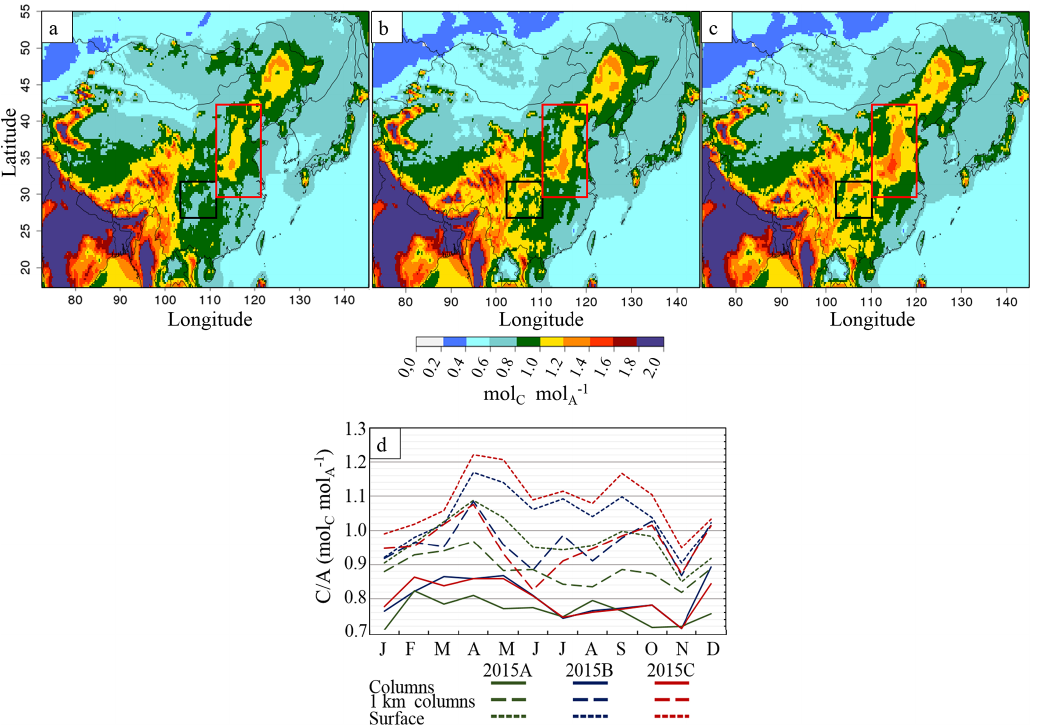
Figure 10. Partial column (0–1km) cation / anion ratio (mol C mol − 1 ) over China for the simulations (a) 2015A, (b) 2015B and (c) 2015C A and (d) monthly variation of C / A ratio over eastern China. Full lines represent ratios derived from columns (up to 12km), dashed lines represent ratios derived from the 0–1km column and dotted lines represent ratios derived from surface concentrations. Black rectangles represent central China, and red rectangles northern